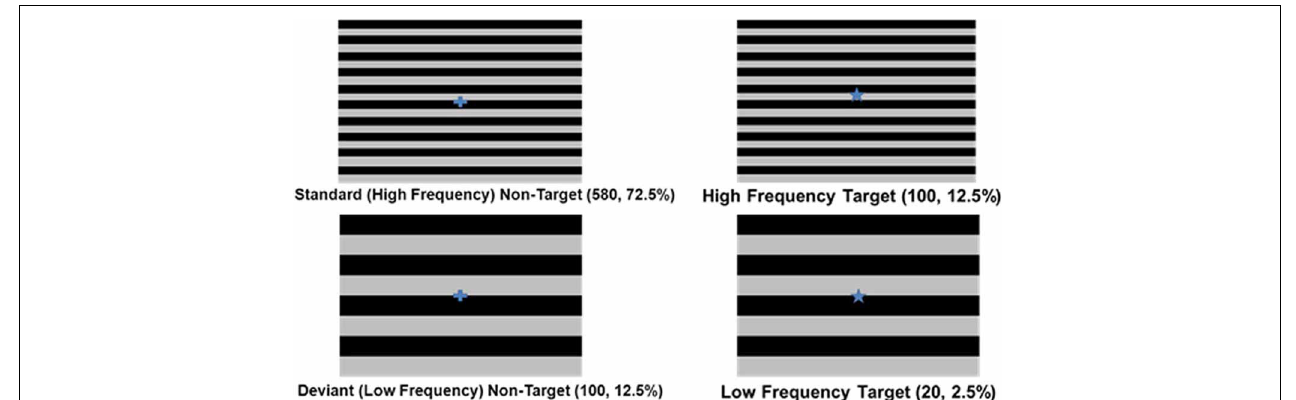
FIGURE 1 | Task stimuli and